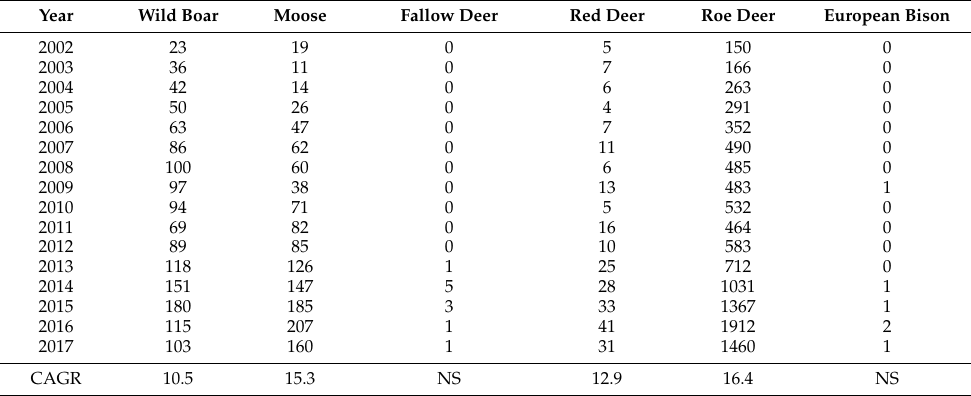
Table A2. Distribution of the annual ungulate–vehicle collisions (UVCs) by animal species.